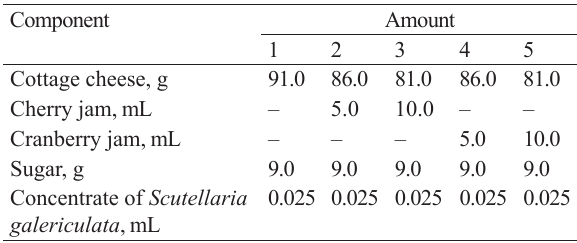
Table 4 Formulation of the cottage cheese fortified with Scutellaria galericulata L. concentrate